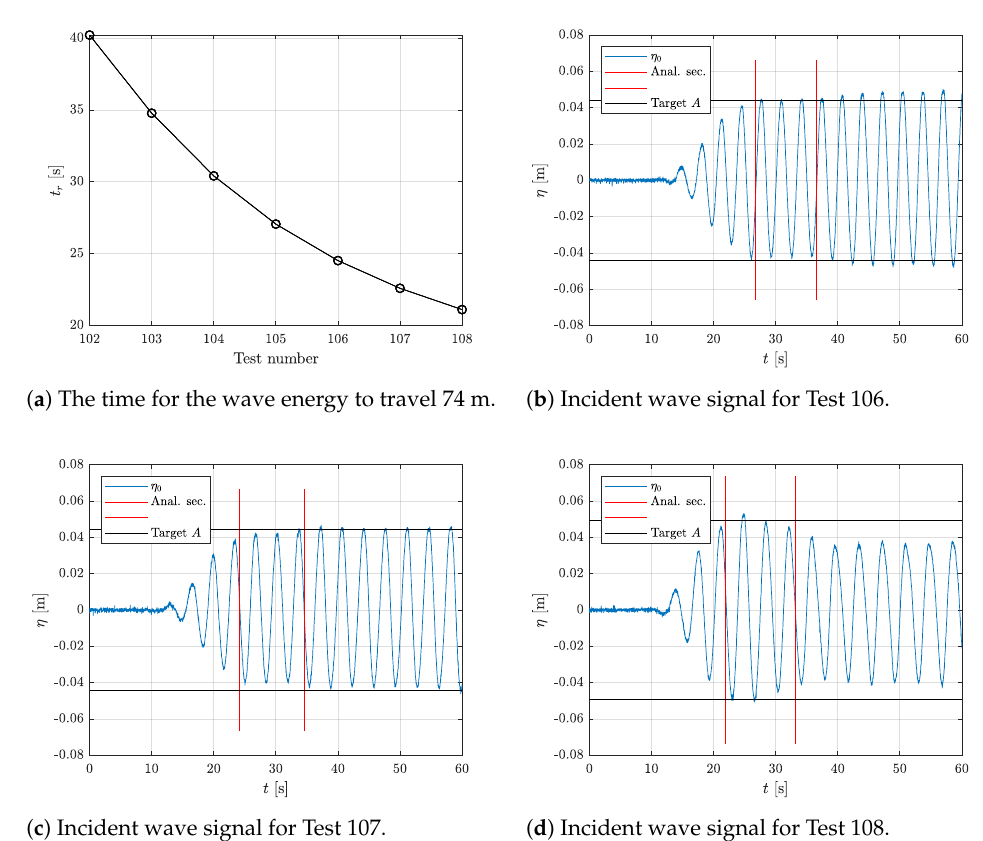
Figure 6. Examples of the incident wave elevations at the chamber, showing the target wave amplitude and the chosen section used for analysis. ( a ) The time for the group velocity to travel from the chamber to the beach and back again (74 m); ( b ) Test 106; ( c ) Test 107; and ( d ) Test